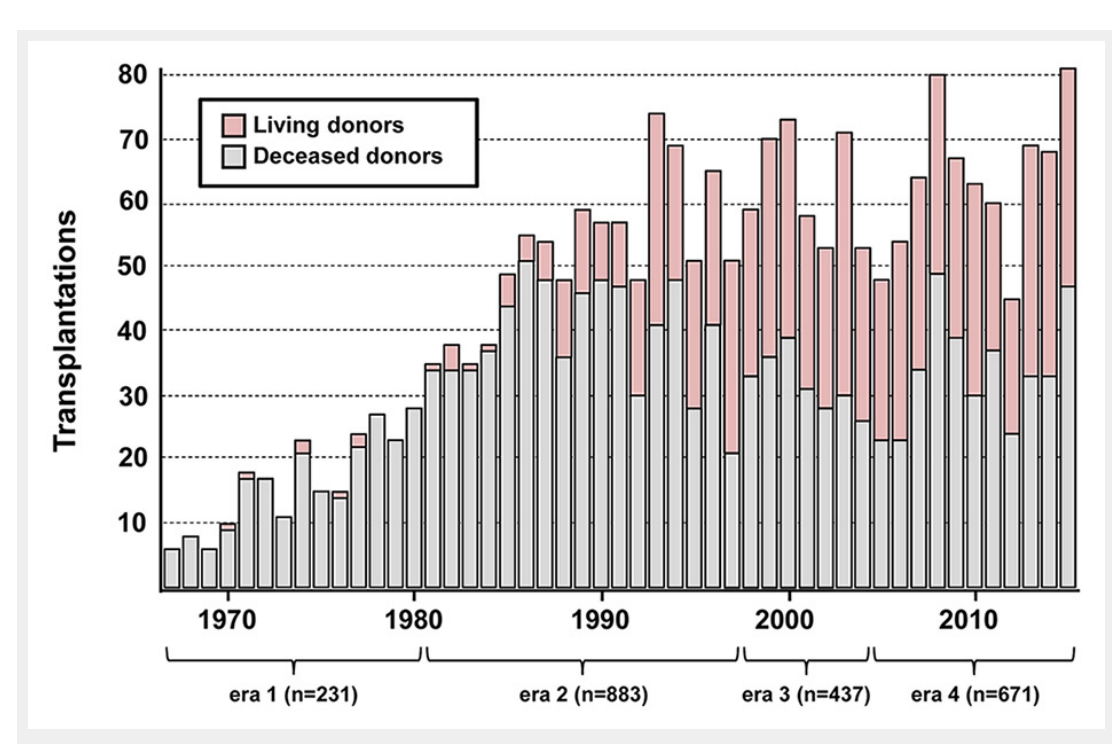
Transplantation frequency at the University Hospital Basel from 1967 until 2015, subdivided into deceased and living donor transplantations. For this figure, the complete number of transplantations in 2015 is